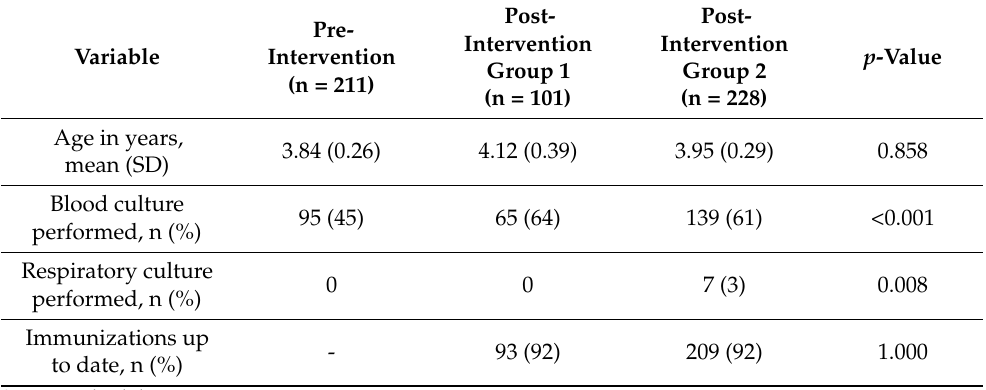
Table 1. Baseline